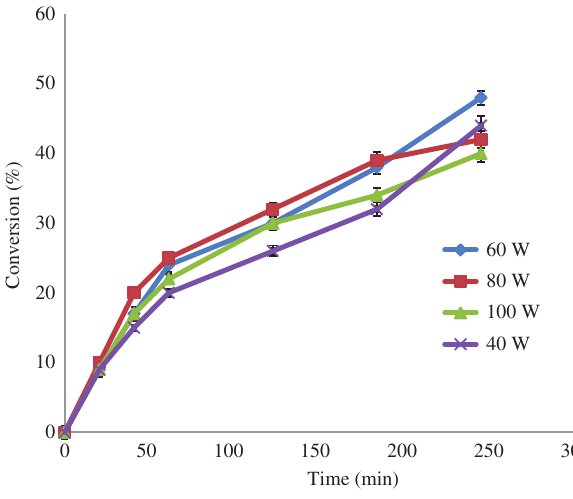
Figure 3: Effect of sonication power on conversion at hexanol:triacetin ratio 1:1, hexane-3 ml, enzyme loading 1% (w/v), temperature 50 ° C, agitation speed 100 rpm, duty cycle 80% and frequency 25 kHz.